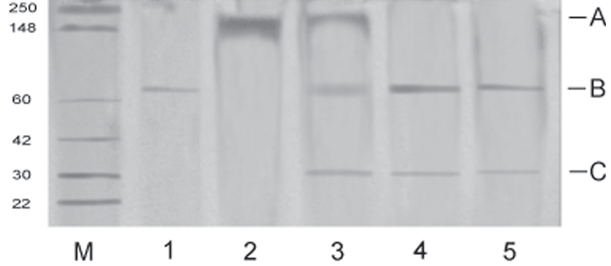
Figure 5. SDS-PAGE analysis of Bt-CryIIA protoxin and its processed form incubated with 0.06 ppm of Mir1-CP. Lane M – markers; lane 1 -processed Bt-CryIIA; lane 2 – unprocessed Bt-CryIIA protoxin; lane 3 - unprocessed Bt-CryIIA protoxin incubated with Mir1- CP for 8 hr; lane 4 – unprocessed Bt-CryIIA protoxin incubated with Mir1-CP for 24 hr; lane 5 – processed Bt-CryIIA toxin incubated with Mir1-CP for 8 hr. Numbers on the left margin refer to the molecular mass of the marker bands in kD. Arrow A indicates the position of the protoxin, arrow B indicates the position of the processed toxin and arrow C marks the position of Mir1-CP (molecular mass of 33 kD) added to the incubation. doi:10.1371/journal.pone.0001786.g005 PLoS ONE |